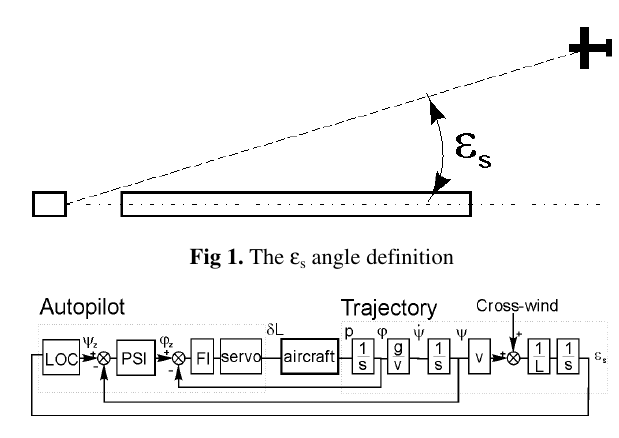
Fig 2. General ILS-LOC Approach Control Scheme, ψ – heading; φ − bank angle; p-roll rate ψ z , ϕ z -expected value; L– distance between LOC and aircraft; V – aircraft velocity; δ L – aileron